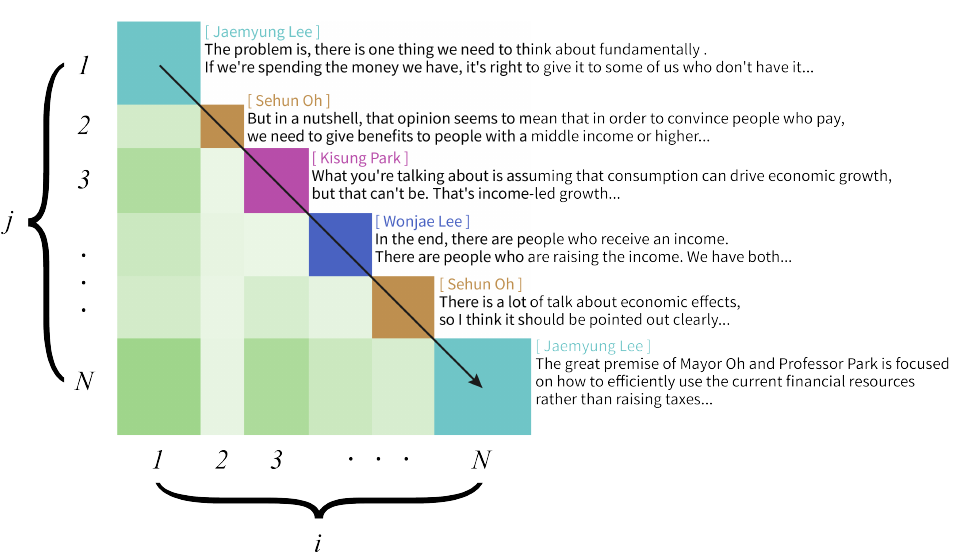
Figure 5. Visualization of conceptual recurrence as a conceptual recurrence plot. The cyan, orange, purple, and blue squares at the top represent utterances. The larger the utterance, the larger the square. The utterances proceed diagonally from the upper left to the lower right. i denotes an index based on the horizontal axis, and j denotes an index based on the vertical axis. For example, these represent the i -th utterance based on the horizontal axis and the j -th utterance based on the vertical axis. A light green square represents conceptual similarity, which means a similarity between the upper utterance and the right utterance. The higher the light green saturation, the higher the conceptual similarity